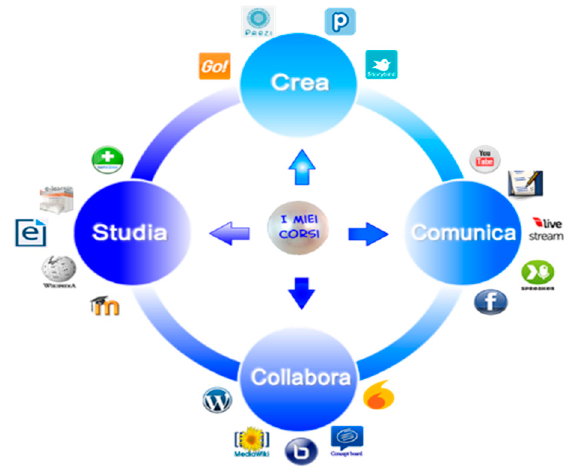
Figure 2. PerLE icon with access to materials, courses, and external software.